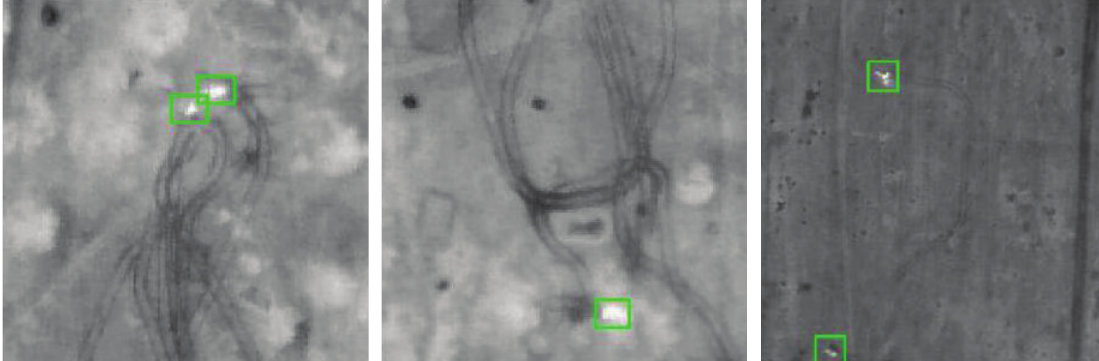
Figure 8: Output Images with Detected